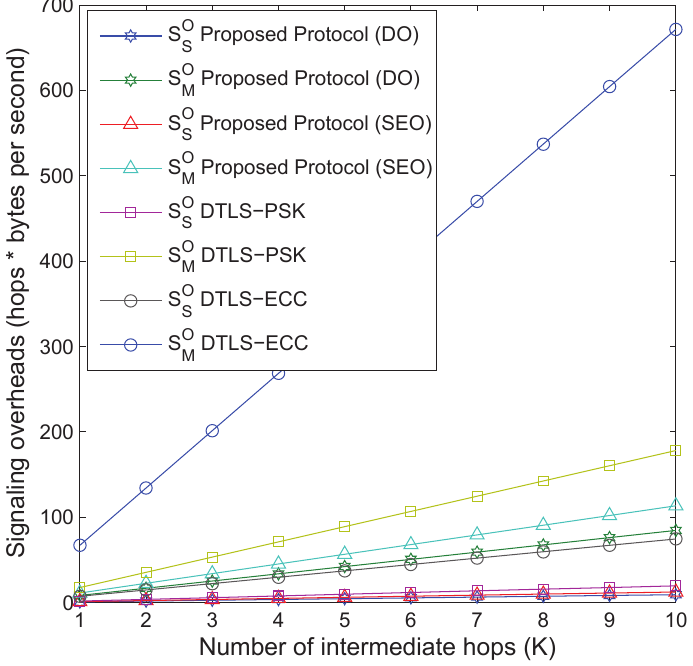
Figure 19. Signaling overheads vs. number of intermediate hops.